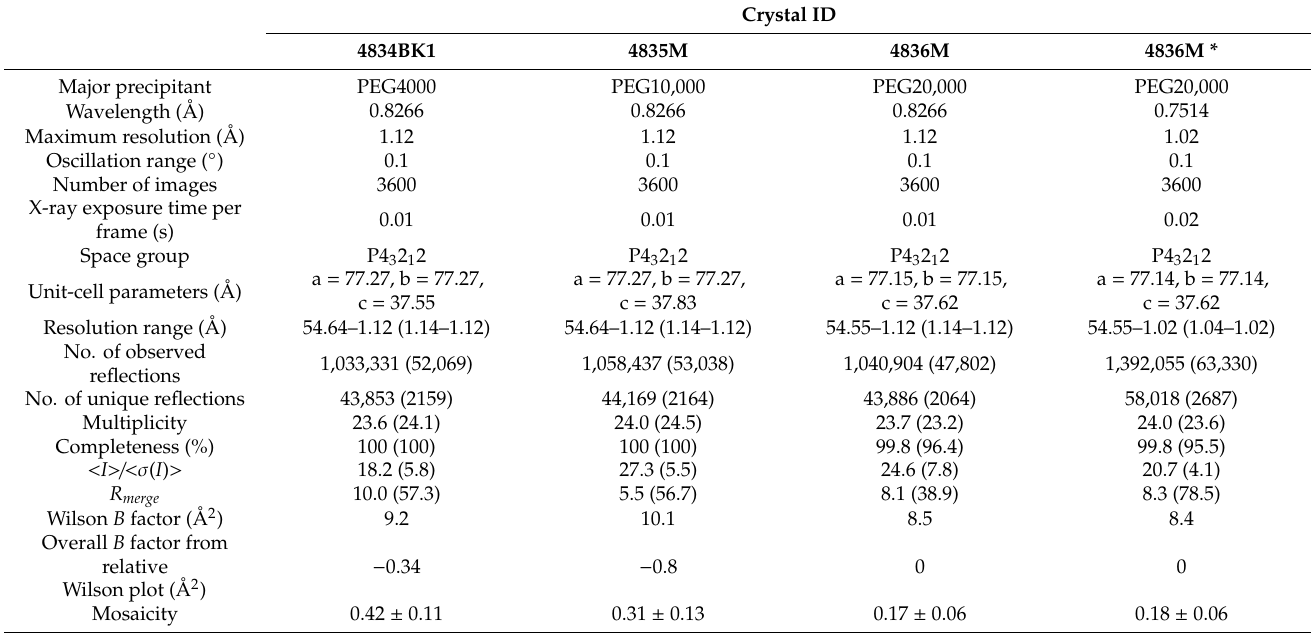
Table 3. Data collection and scaling statistics. The values in parentheses are for the highest resolution shells. Crystal ID 4834BK1 4835M